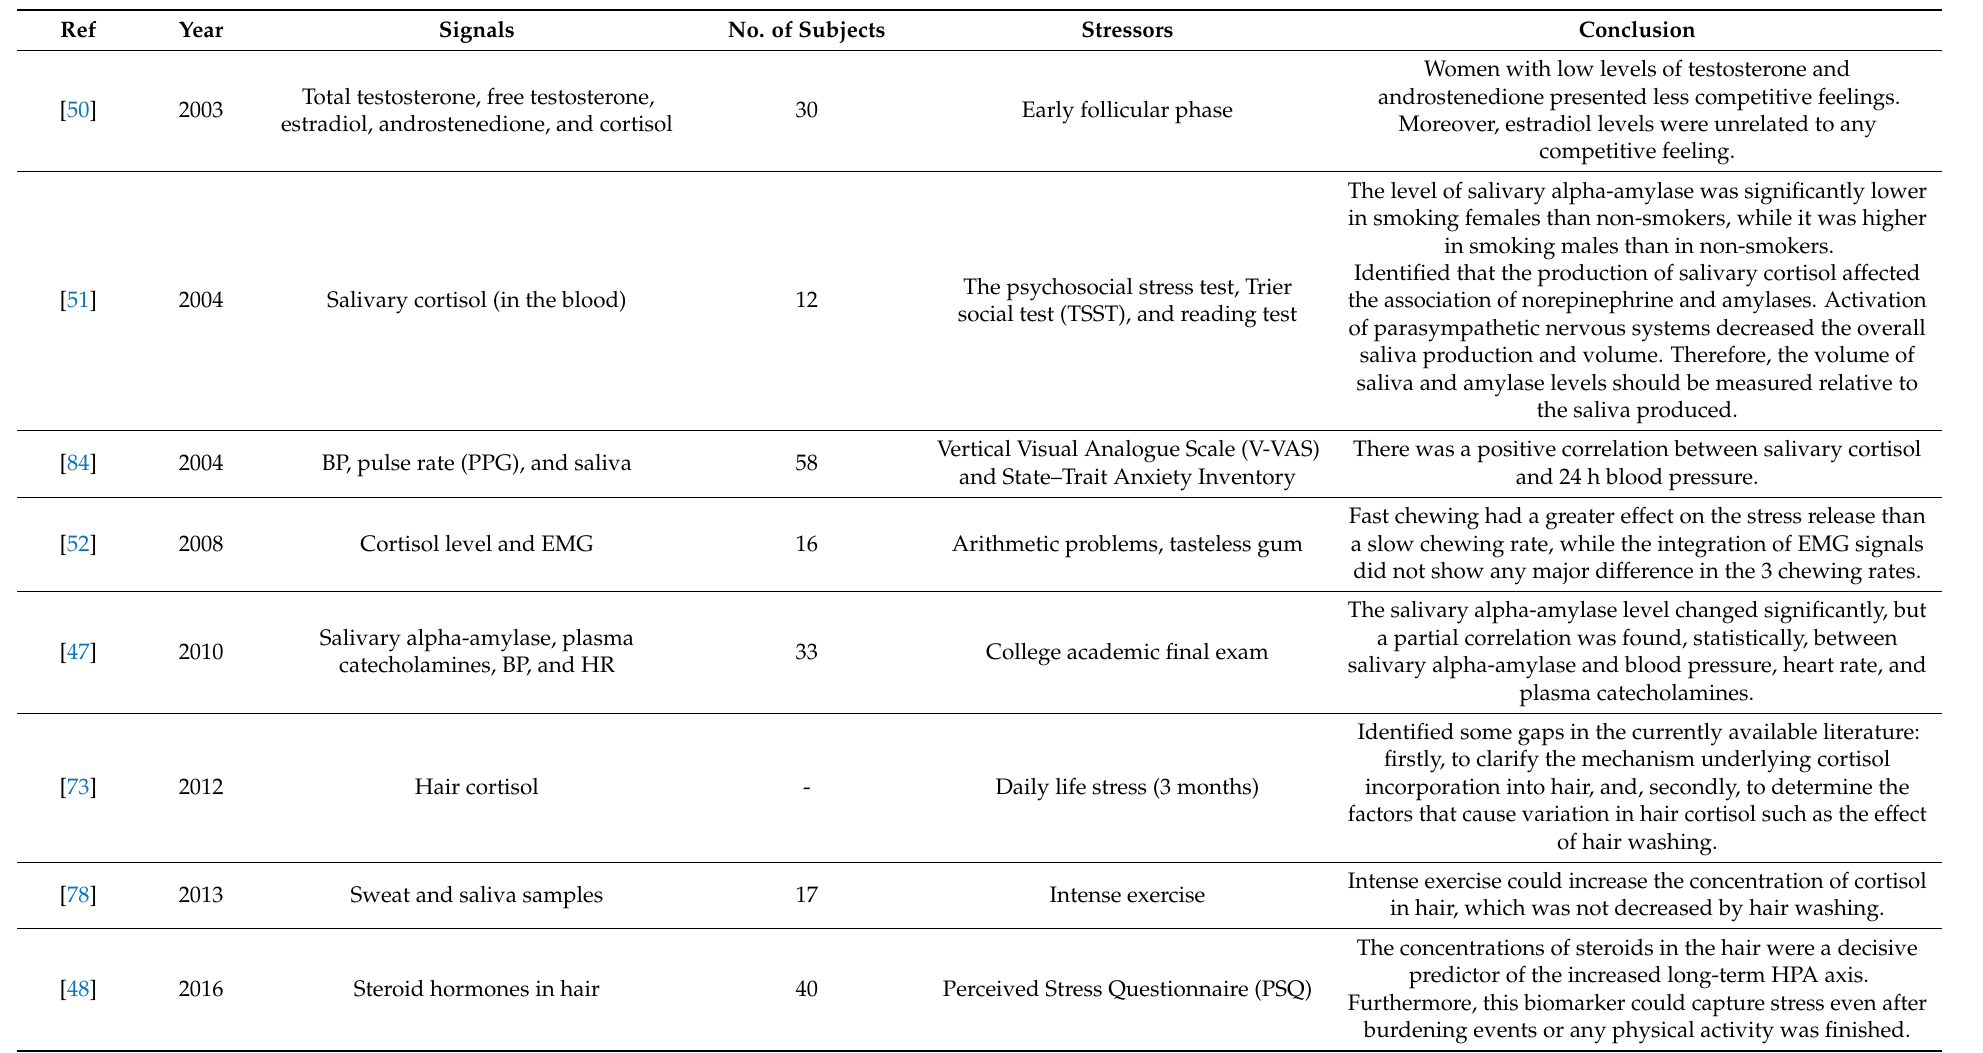
Table 4. Biochemical parameters (sorted